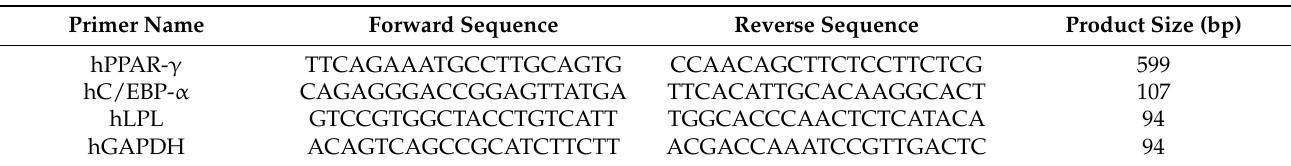
Table 1. List of primers used in the real-time PCR analysis of in vitro